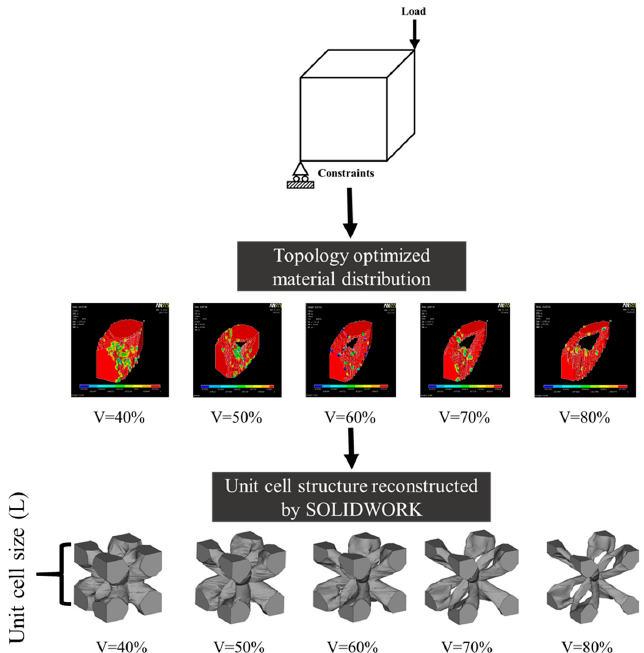
Figure 1. Process of topology optimization (TOP), obtaining the 1/8th unit cell and unit cell after Boolean operation with different porosity.